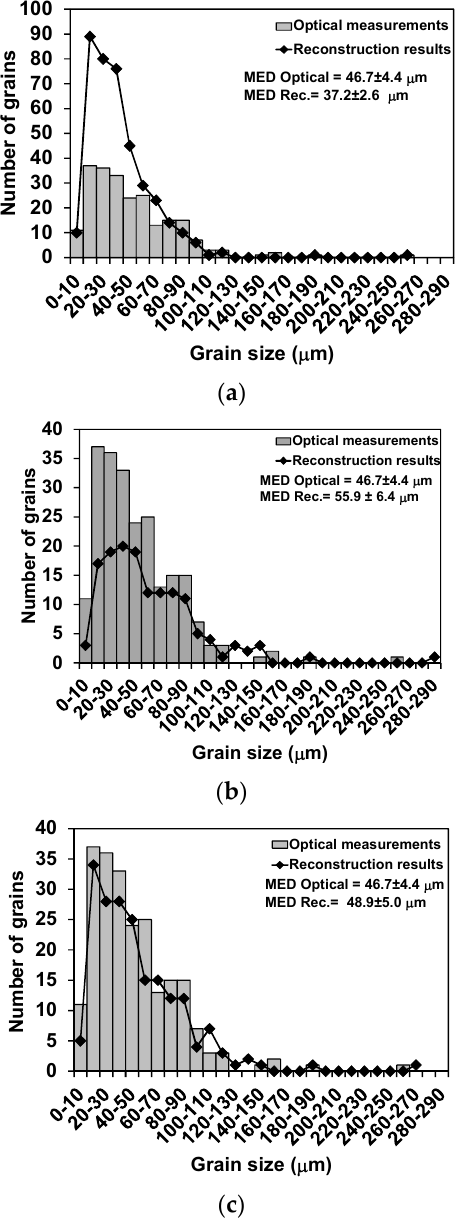
Figure 13 . Comparison of the MED measurements obtained from conventional metallography and the reconstruction procedure for the 1.5 μm step size scan using different criteria for twin boundary definition (4 μm minimum grain size): ( a ) All high angle (>10°) grain boundaries considered;( b ) twins excluded (misorientation criterion (5° tolerance)); and ( c ) twins excluded (misorientation criterion (5° tolerance) + {111} plane coincidence criterion (1° tolerance angle)).